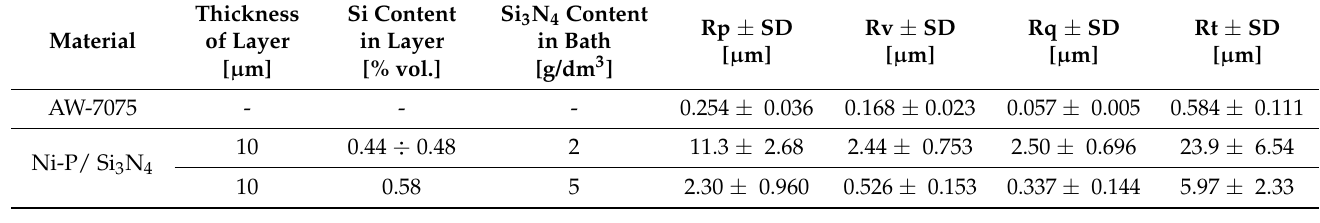
Table 5. Surface roughness test results.